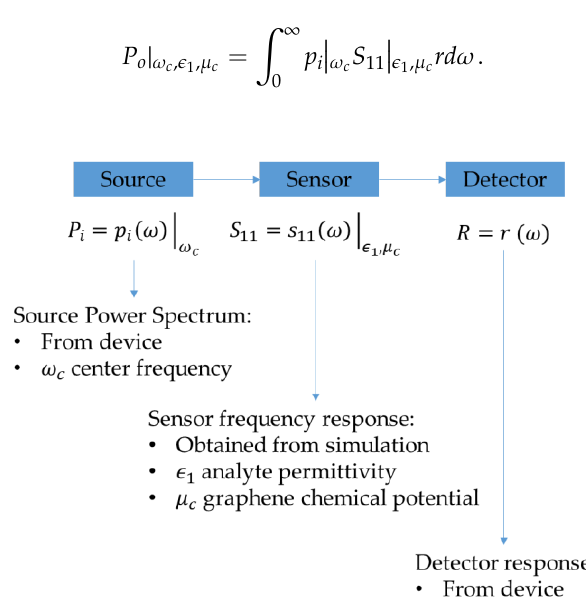
Figure A1. Systematic composition of the sensing setup in frequency Figure B1. Systematic composition of the sensing setup in frequency domain.